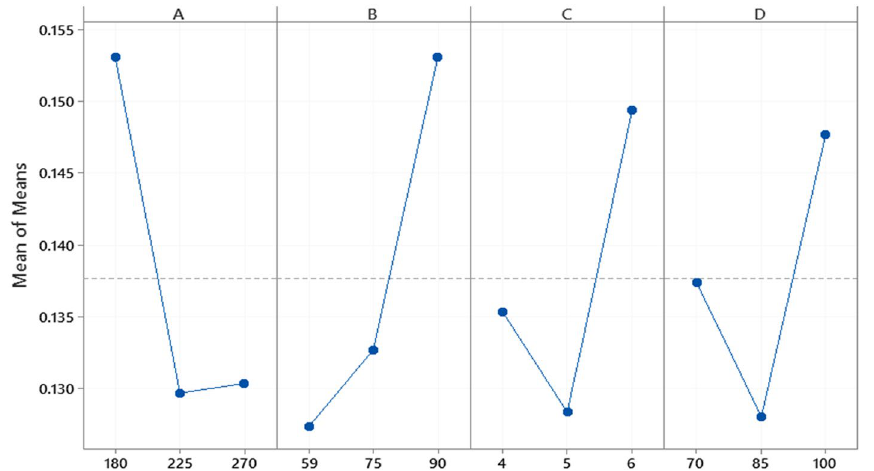
Figure 1. Main effects plot for means.